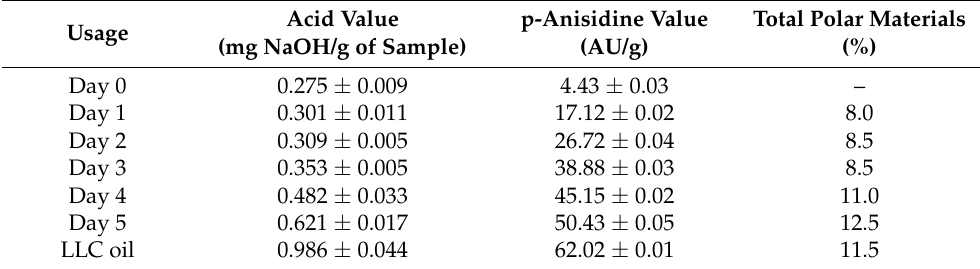
Table 4. Values obtained in fryer oil for acid value, p-anisidine and total polar materials.